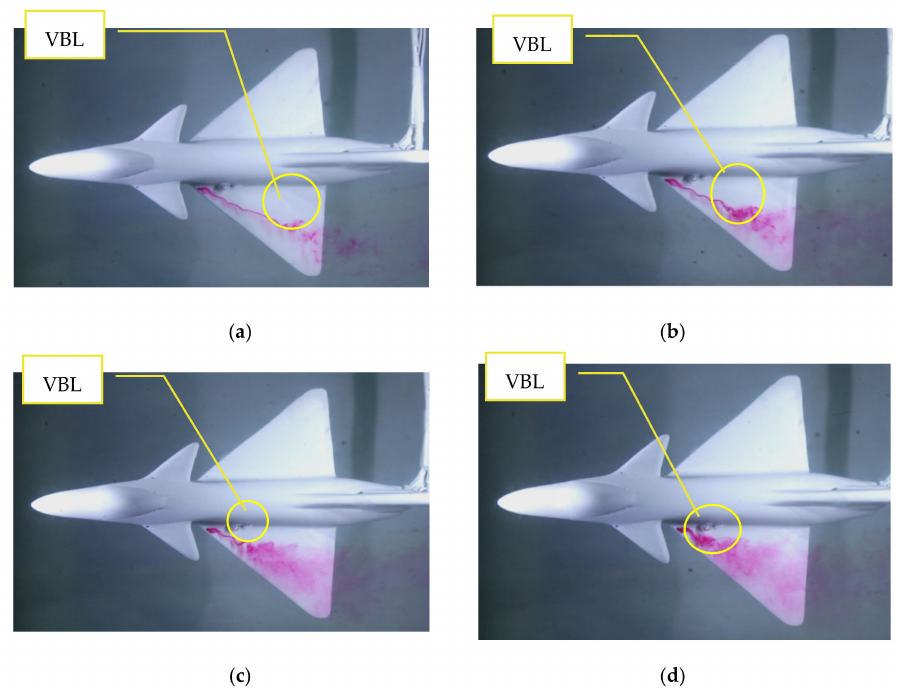
Figure 5. Water tunnel visualization and vortex breakdown location (VBL) on the J-10 model; ( a ) AoA 20 ◦ ; ( b ) AoA 30 ◦ ; ( c ) AoA 40 ◦ ; ( d ) AoA 50 ◦ .